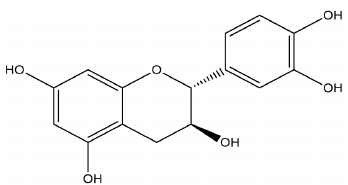
Figure 3. Flavanols (catechin) with gastroprotective and/or anti-ulcer